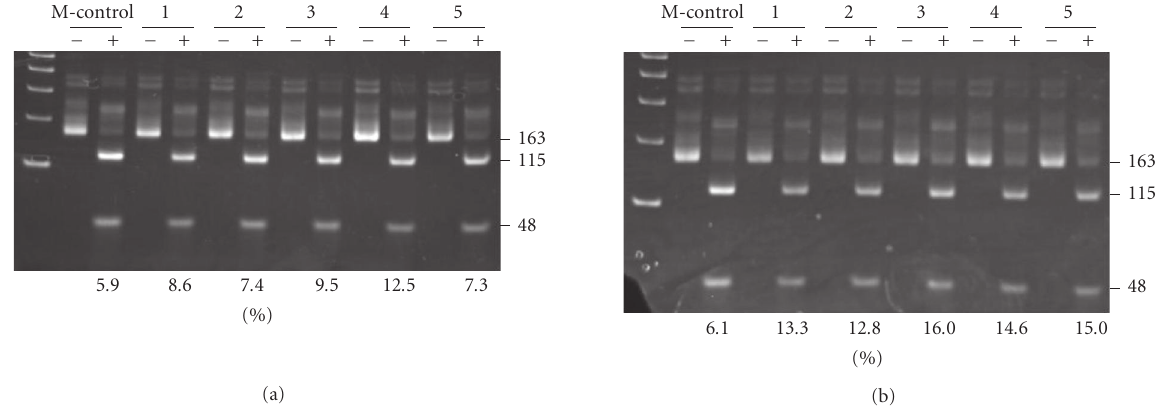
Figure 2: Typical COBRA for LINE-1 cytosine methylation status in the livers of rats fed CD or CS diet for 4 weeks. Numbers shown at the bottom of each lane indicate the percentage of unmethylated cytosine (115 bp band + 48 bp band) versus total cytosine (163 bp band). Panel A: CS livers (#1–#5) after 4-week feeding; Panel B: CD livers (#1–#5) after 4-week feeding. Isolated genomic DNA was treated with sodium bisulfite and PCR-amplified with LINE-1 primers and divided into two portions. The one portion was digested with RsaI (designated with +), the other was not digested (designated with − ), and then both were run on the gel and stained with ethidium bromide. The band at 163 bp was identified as the LINE-1 sequence and those at 115 bp and 48bp were identified as RsaI-digested LINE-1. The numbers on the top of each pair of lanes indicate the rat identification numbers. Lanes designated with M-control are COBRA treated samples obtained from SssI-hypermethylated rat